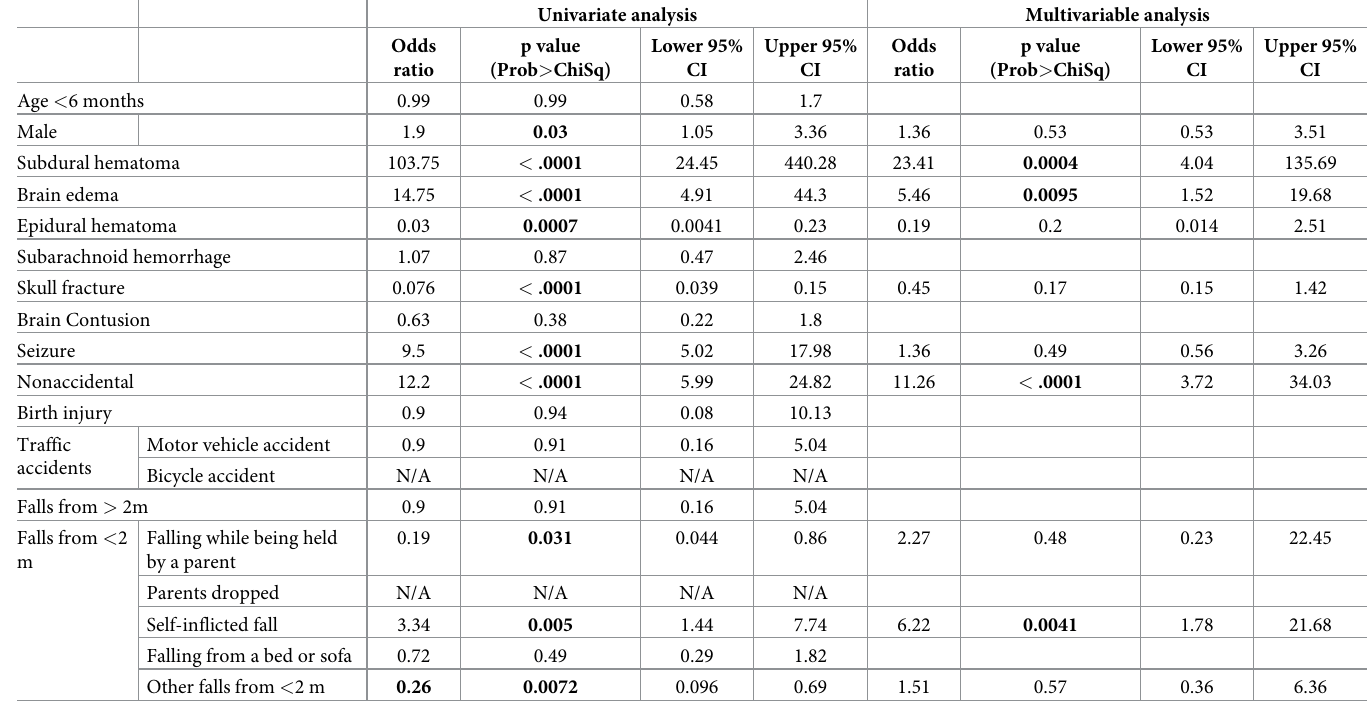
Table 4. Results of univariate and multivariable analyses to examine the relationships between retinal hemorrhage and various factors. Univariate